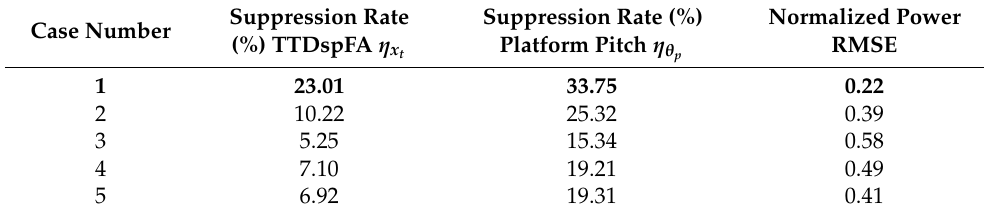
Table 4. Controller performance with respect to TTDspFA and platform pitch. Case Number